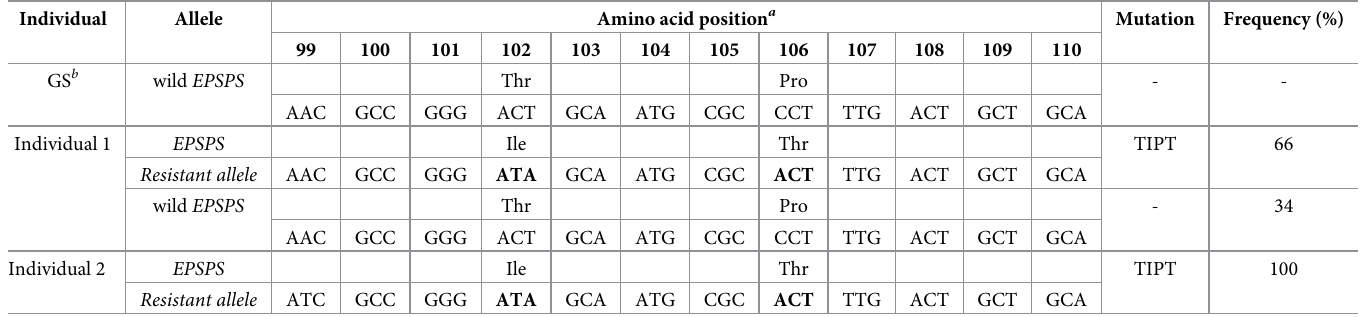
Table 3. Different EPSPS alleles from glyphosate-resistant (GR) wild poinsettia